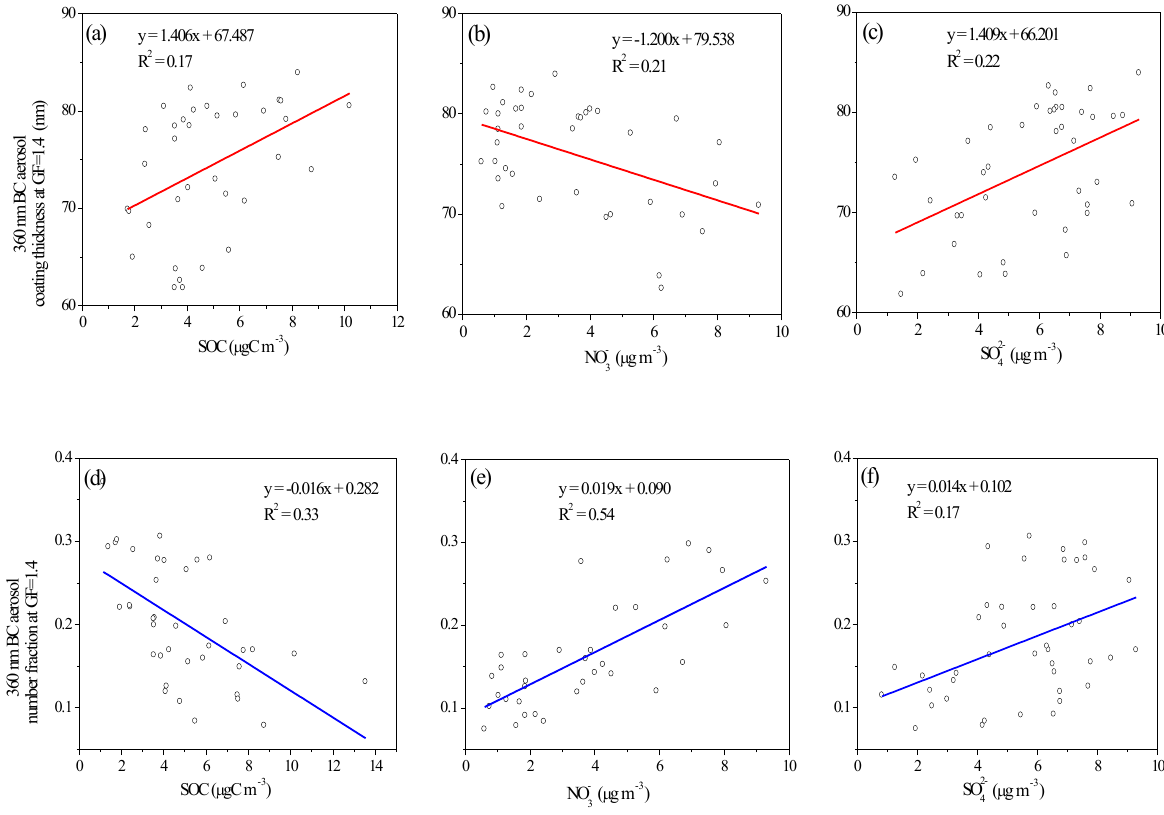
Figure 10. Relations between the coating thickness of 360nm for BC particles with a GF of 1.4 and the concentration of (a) SOC, (b) nitrate, and (c) sulfate; relations between the number fraction of BC particles in 360nm aerosol with a GF of 1.4 and the concentration of (d) SOC, (e) nitrate, and (f) sulfate.